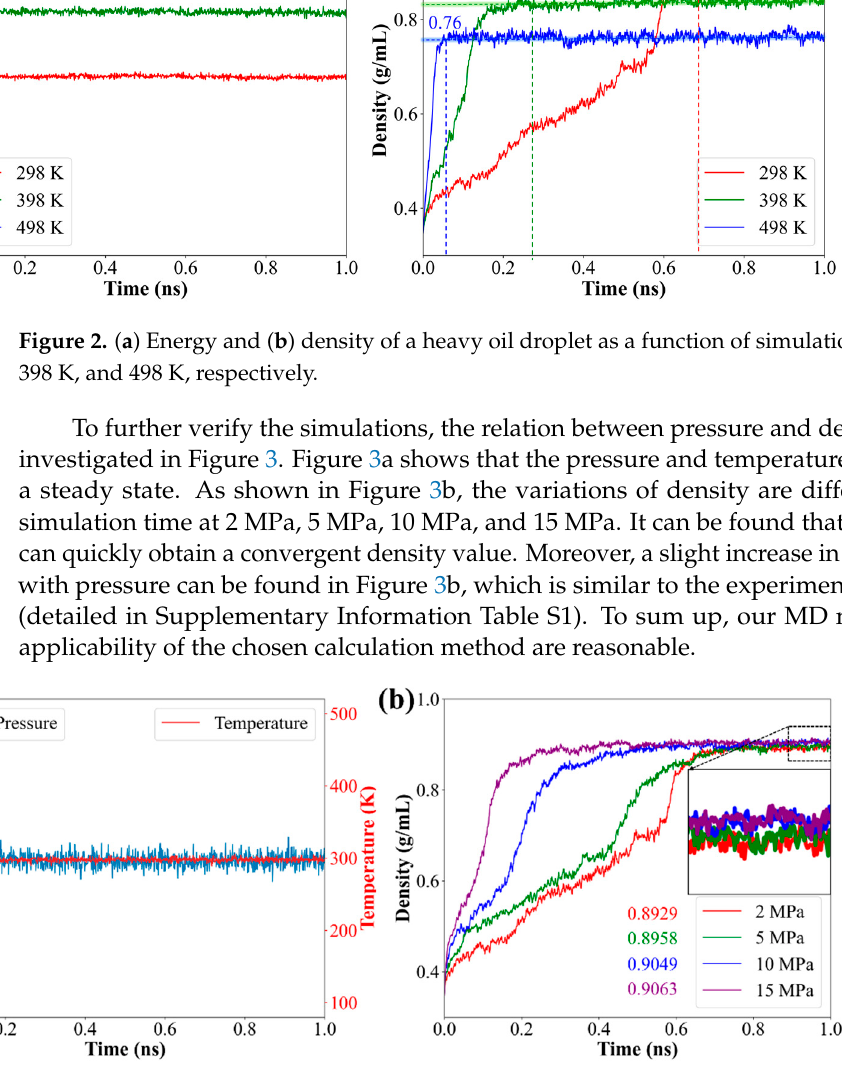
Figure 3. ( a ) Pressure and temperature of a heavy oil droplet at 298 K and 2 MPa as a function of simulation time, ( b ) the density of a heavy oil droplet as a function of simulation time at 2 MPa, 5 MPa, 10 MPa, and 15 MPa, respectively.